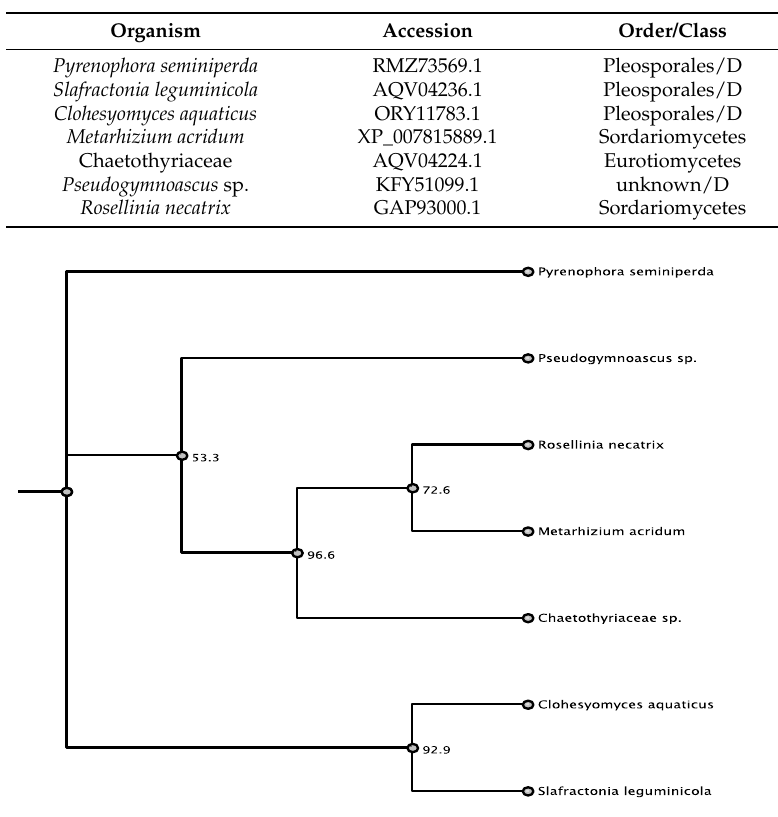
Figure 1. Maximum parsimony tree (MUSCLE alignment and 1000 replicates). Pseudogymnoascus sp. was used as the outgroup. Fungi in tree are pblast results of 58882